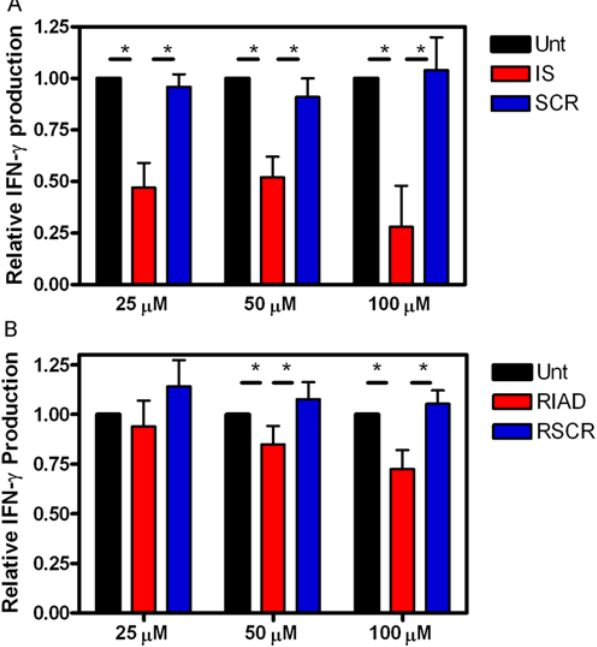
Figure 7. Inhibition of antigen stimulation is mediated by signaling from type II PKA. Allogeneic day 5 dendritic cells (iDC) were incubated without (Unt, black bars) or with A) the indicated concentrations of type II anchoring inhibitor (IS, red bars) or the control (SCR, blue bars), or B) the indicated concentrations of type I anchoring inhibitor (RIAD, red bars) or the control (RSCR, blue bars) for 1 hr at 37 u C, 5% CO 2 . The cells were collected, rinsed and replated. Then 0.1 m g/ml of protein antigen (CFP10) was added for 1 hr at 37 u C, 5% CO 2 , and antigen specific CD4 + clonal T cells were added. IFN- c production was assayed after 16 hours by ELISPOT. Data are an average of three donors. Error bars are S.E.M. Student ttest reveals significance, P ,